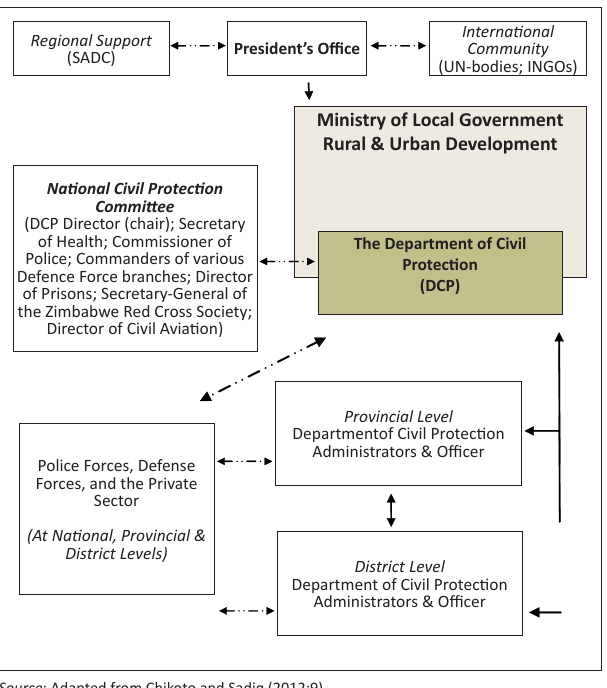
FIGURE 1: The structure of Zimbabwe’s Disaster Management Policy